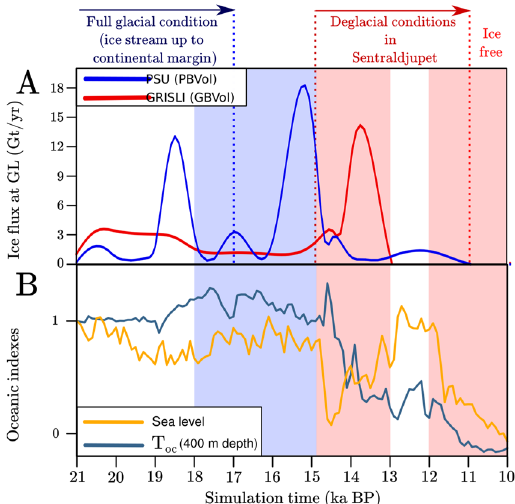
Figure 4. ( A ) Time evolution of the ice flux at the grounding-line along the Bjørnøyrenna Ice Stream cross section AB shown in Fig. 1 in GBvol (red line) and PBvol (blue line) simulations. When the ice flux at the grounding-line approaches zero, the Bjørnøyrenna Ice Stream can be considered as fully retreated. The Bjørnøyrenna Ice Stream retreat history according to geological data 4–6 is summarized at the top of the plot. Red/blue shades highlight periods of warm/cold annual mean ocean temperature (400 m depth) and high/ low global sea level prescribed in the ISM simulations. ( B ) Indexes for the annual mean ocean temperature in the South-western Barents Sea at 400 m depth (dark blue line) used to interpolate between LGM and PI ocean conditions and for the regional sea level (dark yellow line). The ocean temperature index is based on the Trace- 21ka fully coupled transient simulation 22 , whereas the regional sea level index is based on the NGRIP δ 18 O record 29 . Red/blue shades highlight periods of warm/cold annual mean ocean temperature (400 m depth) and high/low global sea level prescribed in the ISM